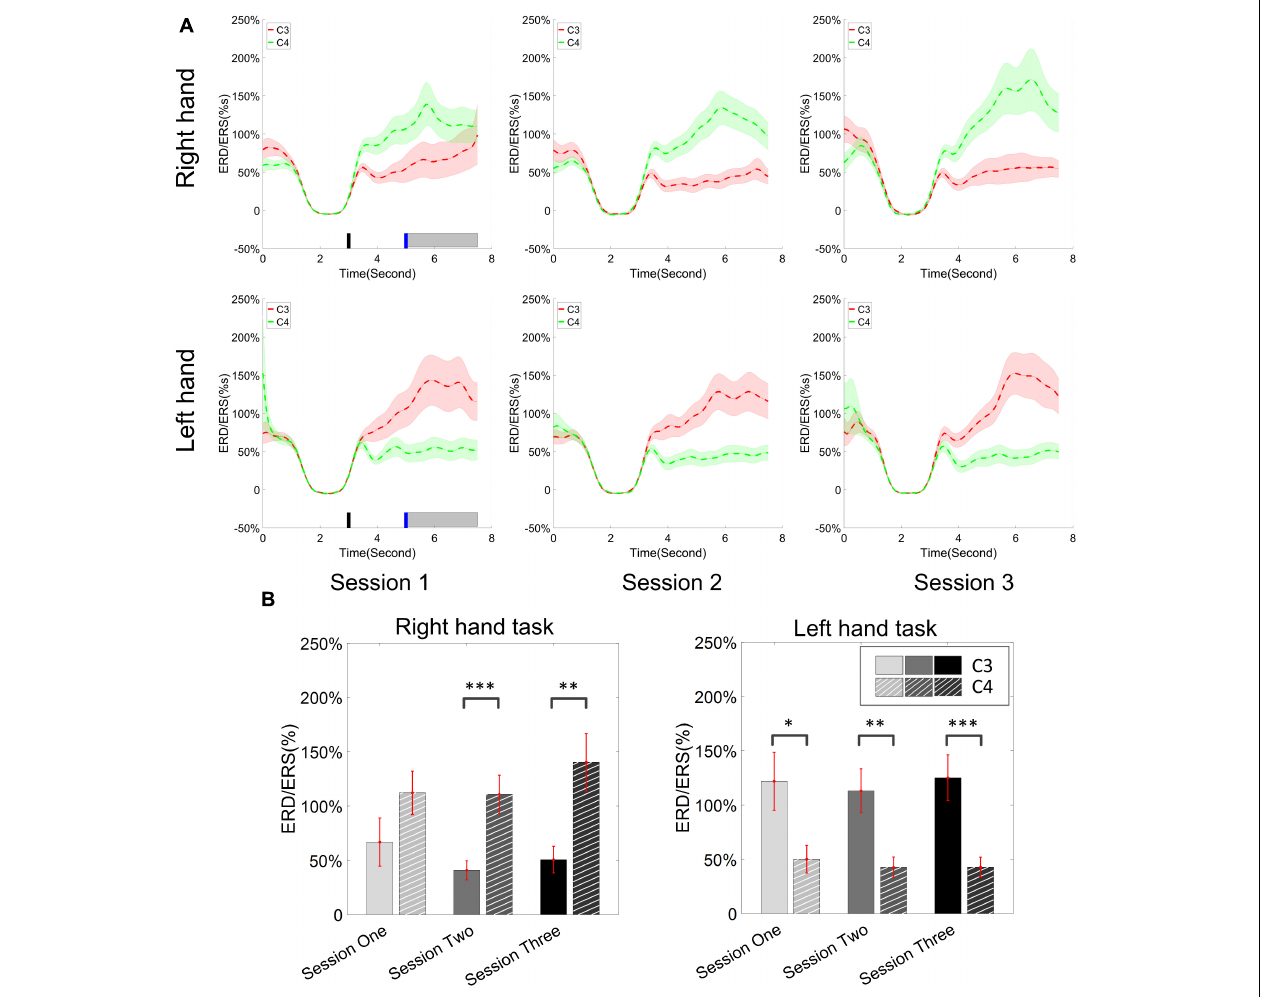
FIGURE 6 | ERD/ERS value and its statistics. All of the trials were used for the calculation of ERD/ERS values. (A) The time varying group average of ERD/ERS value for the right hand task (the upper row) and left hand task (the bottom row) across the three training sessions. The target cue appeared at the end of second 3 and the cursor feedback began at the end of second 5. (B) The grand average ERD/ERS values during the period of [5–7.5]s, which was marked in gray bar area in subplot (A) , were compared for right hand tasks and left hand tasks, separately. The statistical analysis showed a significant difference between channel C3 and C4 during each session for the left hand task, on sessions 2 and 3 for the right hand task; no significance was found among the session pairs across the training. ∗ p < 0.05, ∗∗ p < 0.01, ∗∗∗ p <